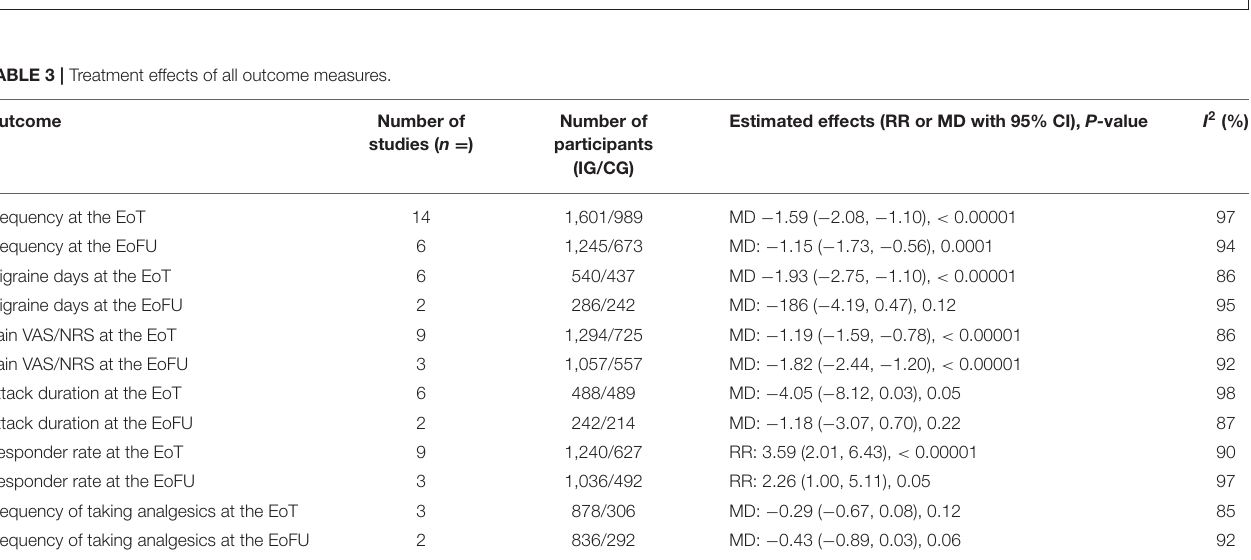
FIGURE 3 | Meta-analysis for migraine frequency at the end of treatment.